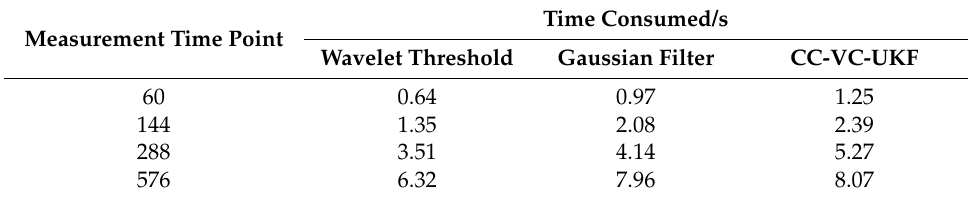
Table 2. Time used for filtering and cleaning by different algorithms.